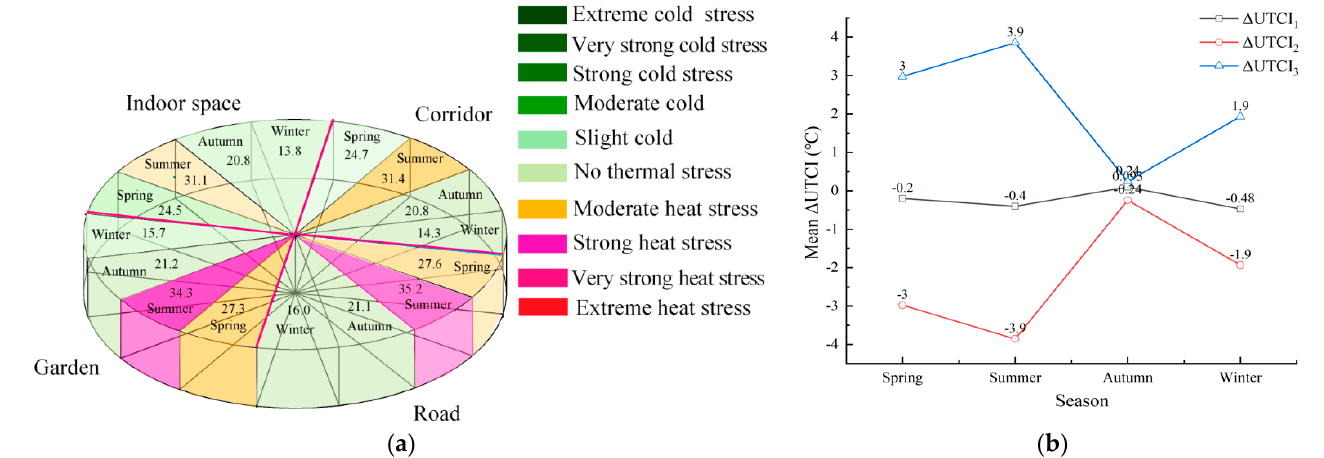
Figure 8. ( a ) The seasonal mean UTCI values of the four spaces; ( b ) The seasonal Δ UTCI values of the four spaces.